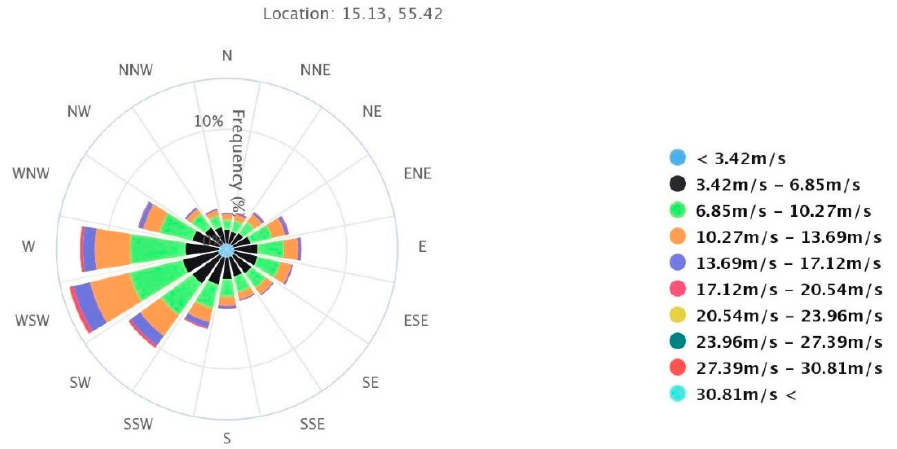
Figure 3. Wind rose near the Island, for the period 01.01.1979 to 31.12.2016.